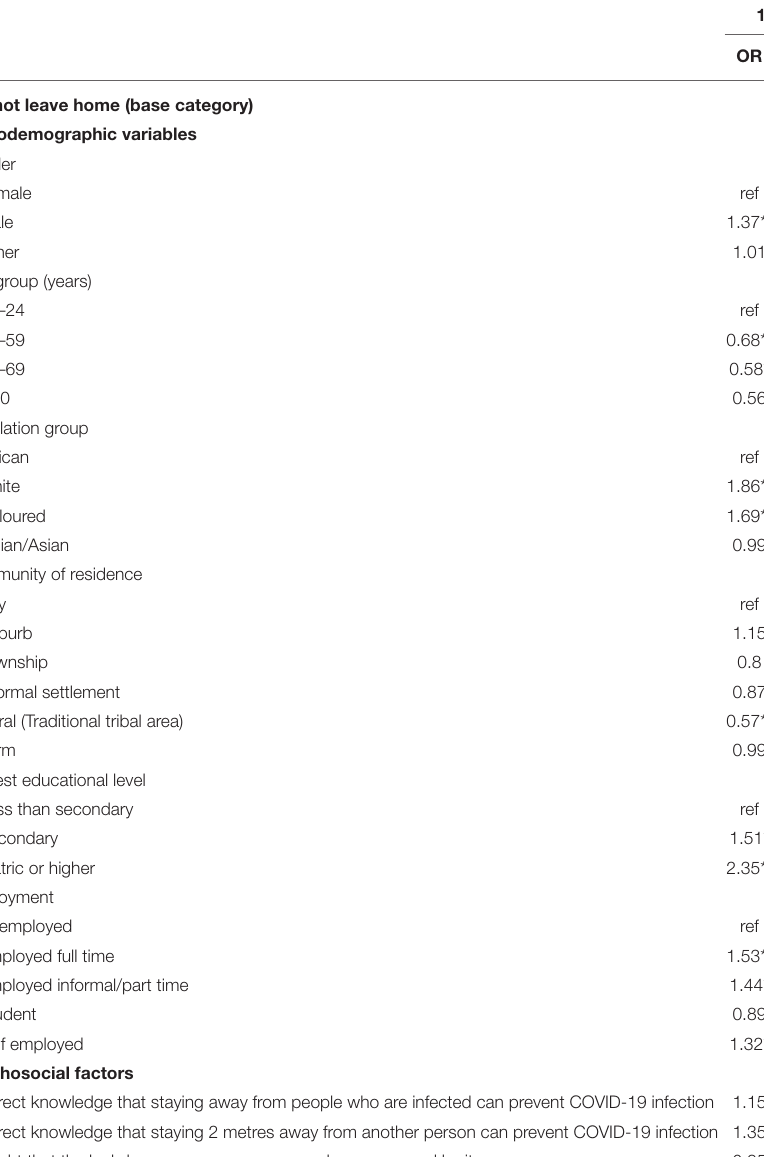
TABLE 3 | Multiple multinomial regression showing factors associated with being in contact with 1–10, 11–50 and > 50 people when outside the